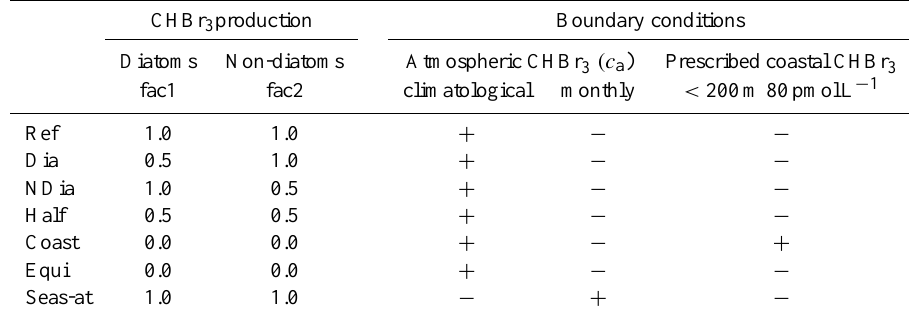
Table 1. Model experiments. All experiments consider the degradation processes described in Sect.